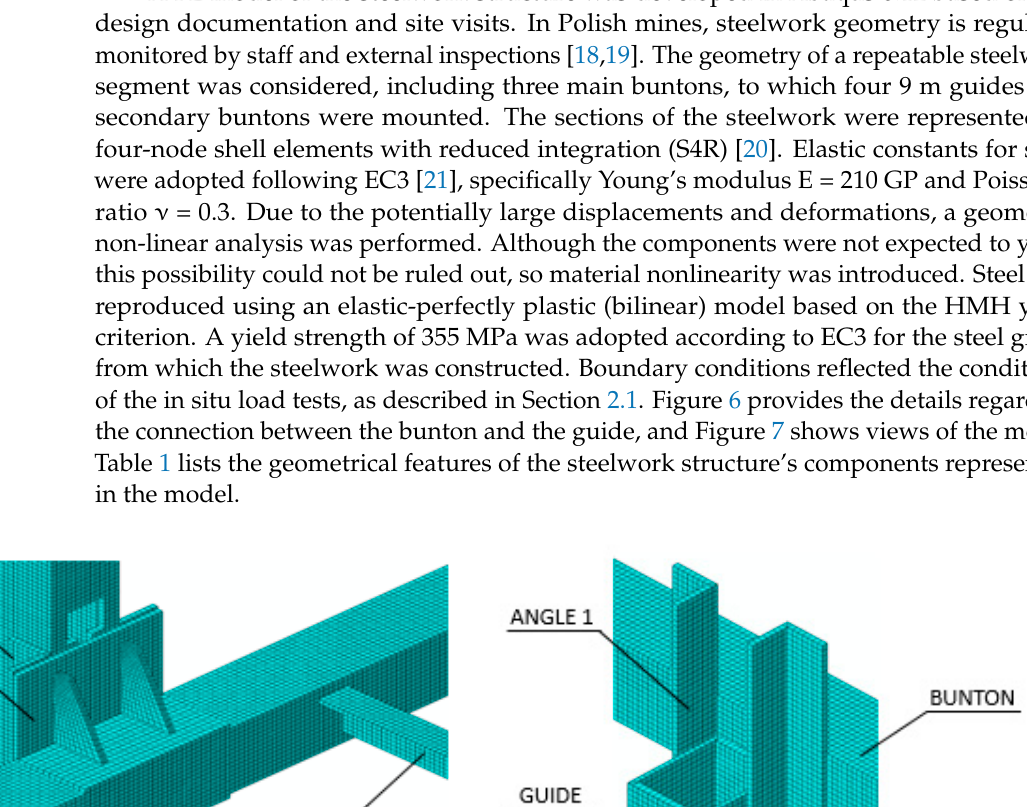
( b ) Figure 7. Views of the model from the ( a ) front, ( b ) side, and ( c ) top.